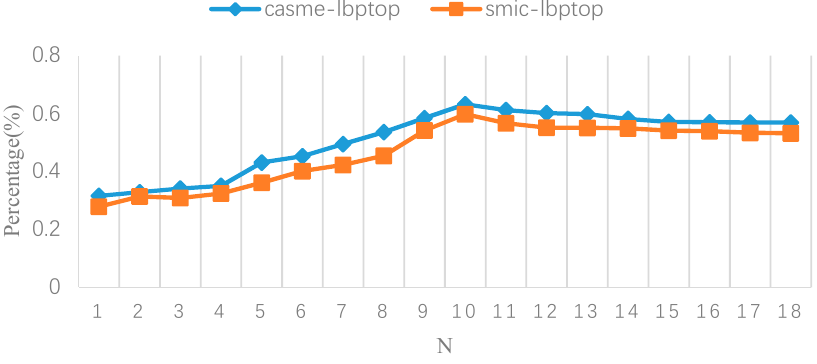
Figure 7. Recognition accuracy (%) of numbers of NMPs. Table 5. Accuracy rate and NMPs numbers of different feature selection algorithms.